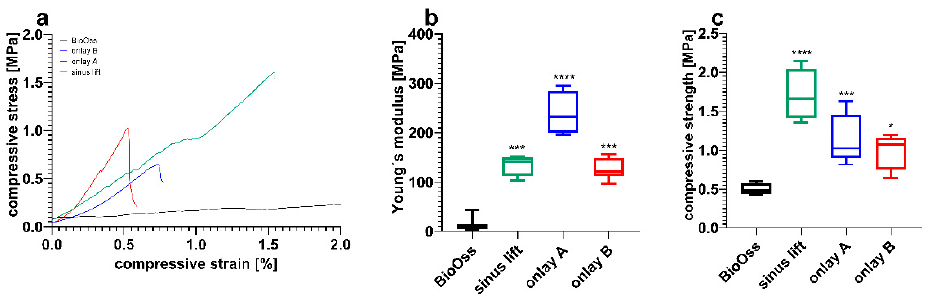
Figure 10. Mechanical properties of individual scaffolds in comparison with BioOss ® . ( a ) Representative compressive stress–strain curves. ( b ) Young’s modulus and ( c ) compressive strength determined from the curves (* p ≤ 0.05, ** p ≤ 0.01, *** p ≤ 0.001, **** p ≤ 0.0001, mean ± standard deviation, n = 5).